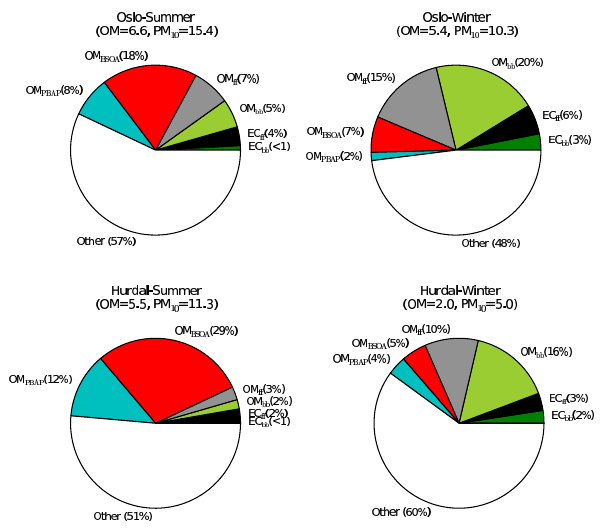
Fig. 3. Estimated contribution of carbonaceous matter components to PM 10 . Estimates use central values from LHS analysis. OM, PM 1 numbers in parenthesis give total aerosol concentrations and OM in µgm − 3 . See Sect. 5.7 for assumed OM:OC